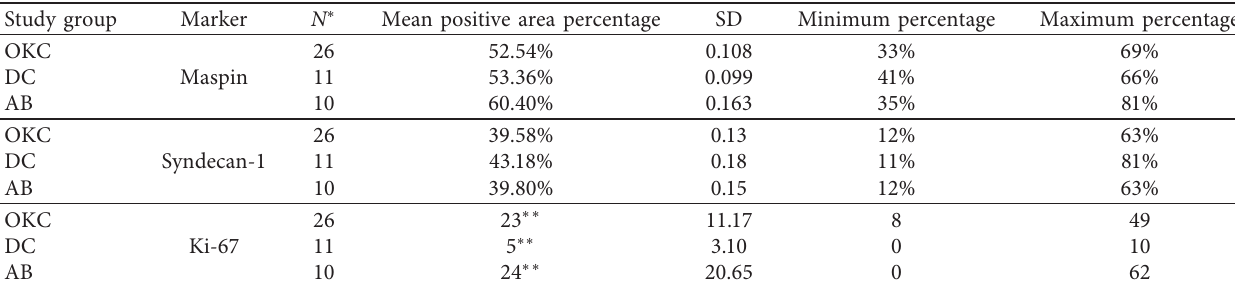
Figure 3: Immunohistochemical expression of Ki-67 (a) in OKC epithelial lining, (b) in DC epithelial lining, and (c) in AB (original magnification × 400). Table 1: Frequency distribution of the mean, standard deviation (SD), minimum, and maximum values of the percentages of maspin- positive areas, syndecan-1 positive areas, and the Ki-67 scores in the three study